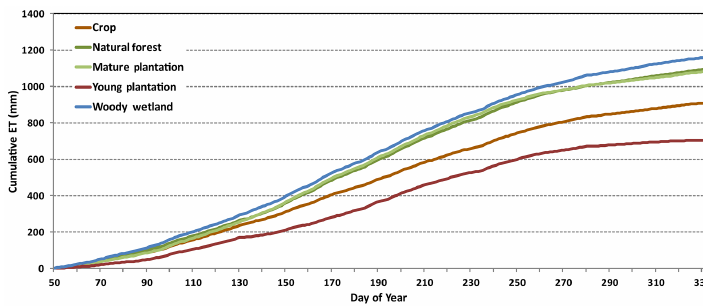
Figure 13. Seasonal cumulative ET for different land cover types.